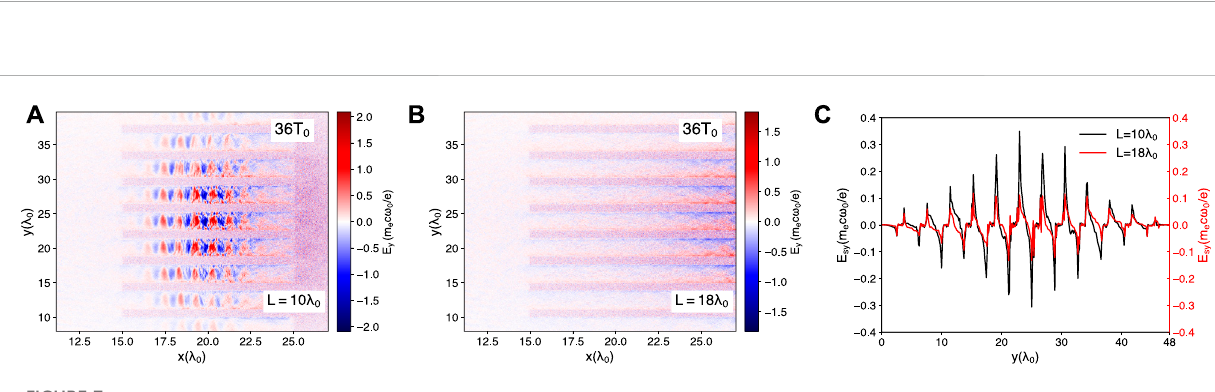
S . (C) For the fi xed S = 2.8 λ 0 and L .